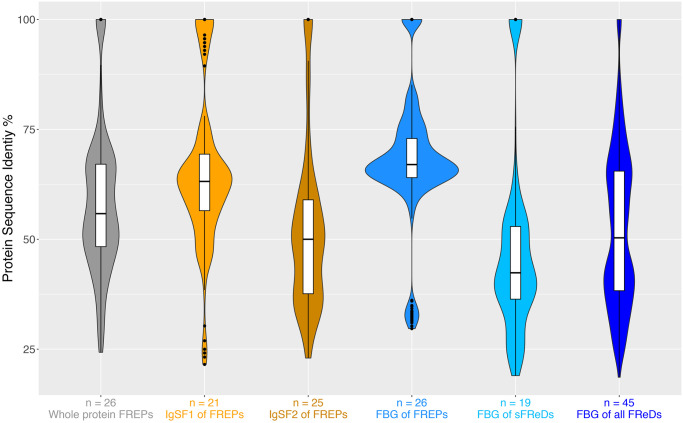
Violin plots of protein sequence-pairwise identity analyses of IgSF1, IgSF2, and FBG domains in B. glabrata FReD genes.The 26 complete FREP protein sequences, and complete FBG domain sequences from all FReD genes in B. glabrata were used for pairwise blast identity analysis. Number under each Violin plot at x-axis is the number used for each assigned analysis, and y-axis represents percentage of protein sequence identity (%).